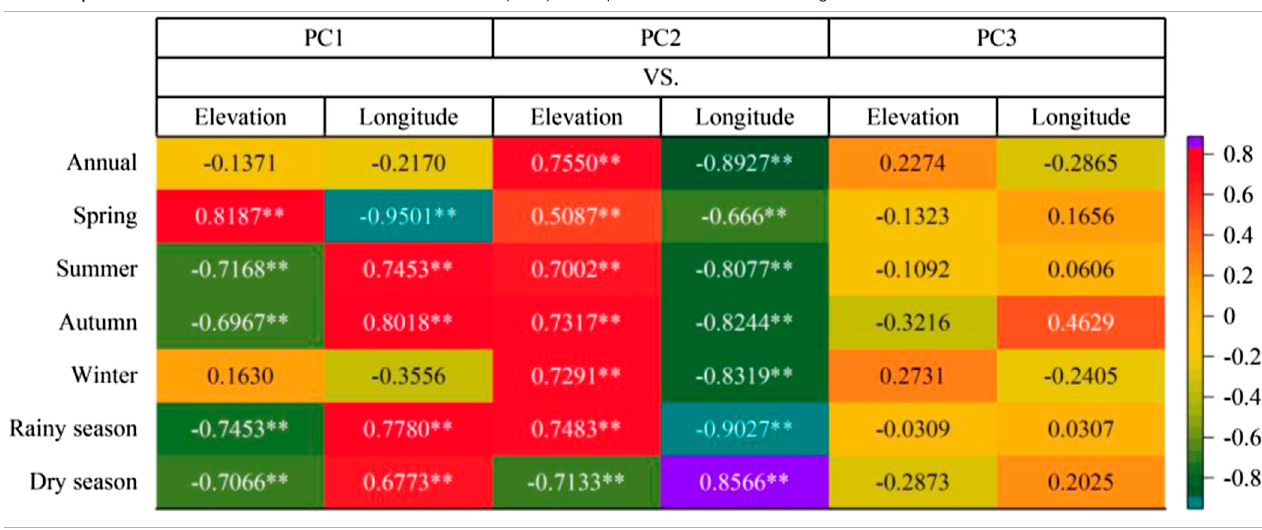
TABLE 2 | Linear correlation coef fi cients R between the fi rst three principal components of the YGP and longitude and elevation.